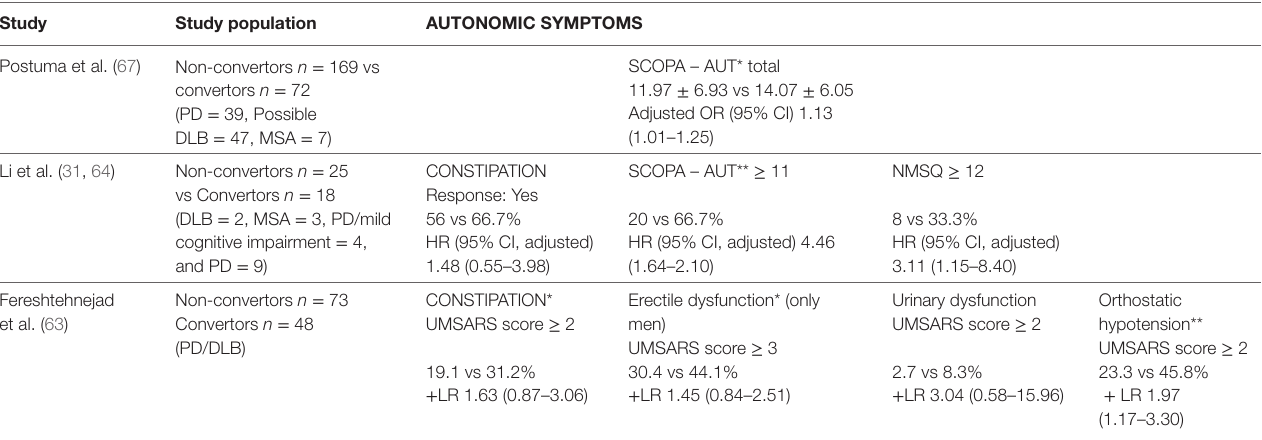
TABle 4 | Predictive value of autonomic symptoms for phenoconversion in idiopathic RBD